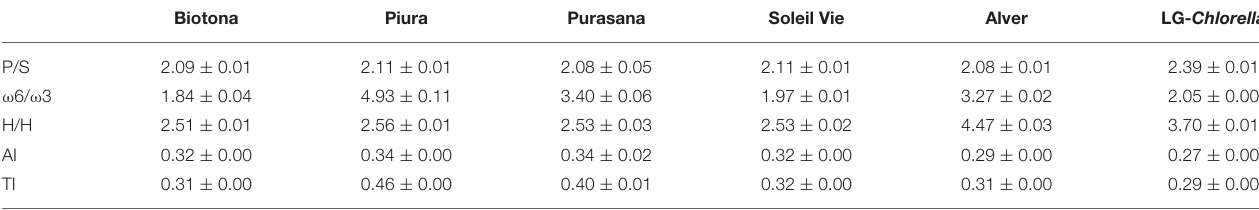
TABLE 4 | Nutritional quality indexes of the lipid fraction of the analyzed microalgal biomasses.